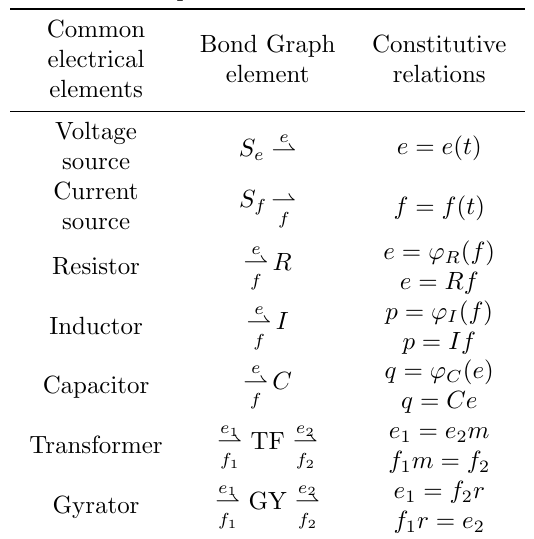
Table 2: Common electrical elements and their proper Bond Graph indicators and relations